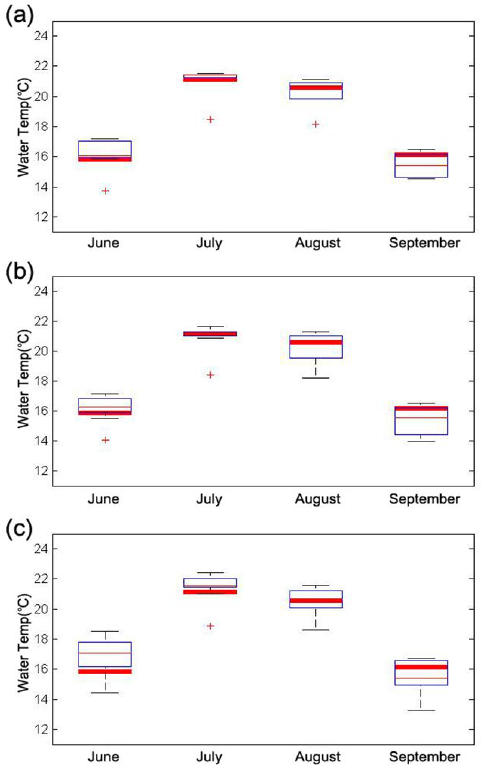
Figure 9 . Boxplot of daily water temperature (2016 to 2096 years) in summer season: (a) RCP 2.6 (9 climate models); (b) RCP 4.5 (12 climate models); and (c) RCP 8.5 (12 climate models) climate scenarios and bold red line indicate monthly median water temperature for observed period (2011 to 2014).